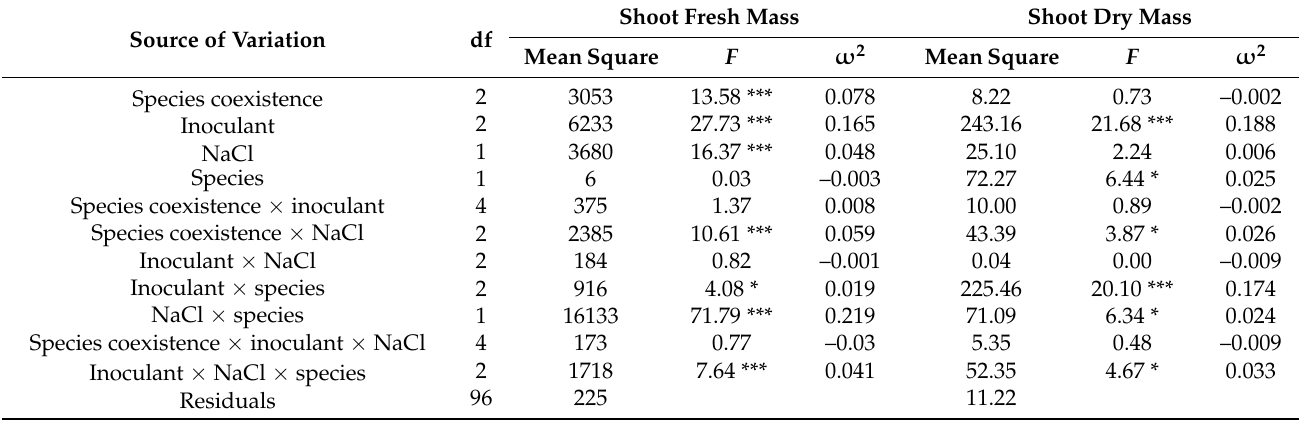
Table 5. ANOVA analysis of shoot mass parameters.